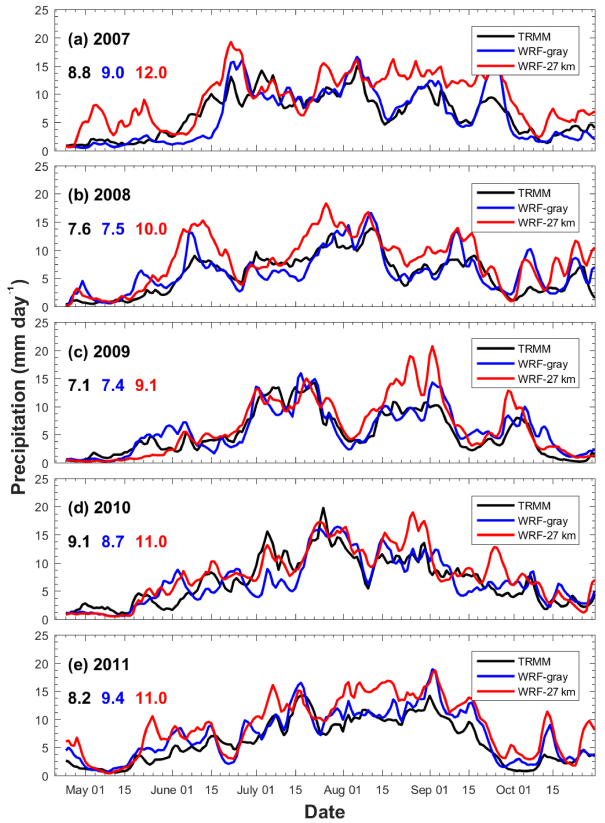
Figure 4. Temporal evolution of KELLJ indices in (a) 2007, (b) 2008, (c) 2009, (d) 2010, and (e) 2011 from ERA-Interim (black lines), WRF-gray (blue lines), and WRF-27km (red lines). A 5-day moving average is applied to the time series.